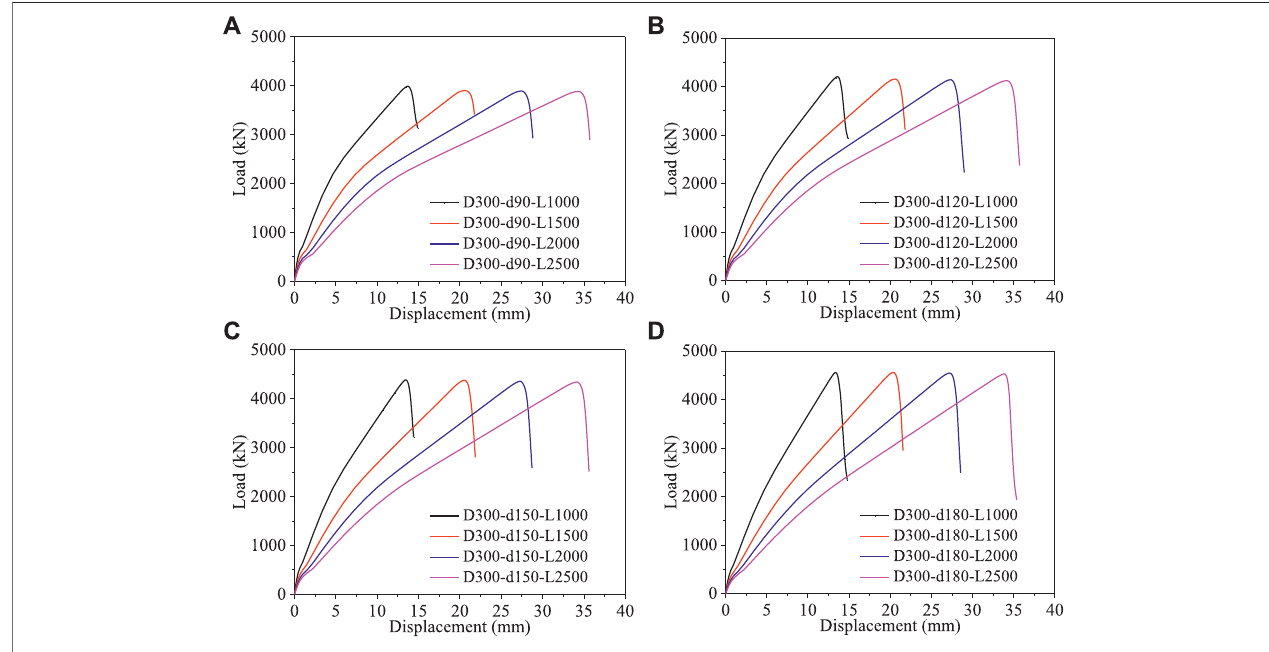
FIGURE 11 | In fl uence of the length of columns ( D o = 300 mm). (A) χ = 0.3. (B) χ = 0.4. (C) χ = 0.5. (D) χ = 0.6.